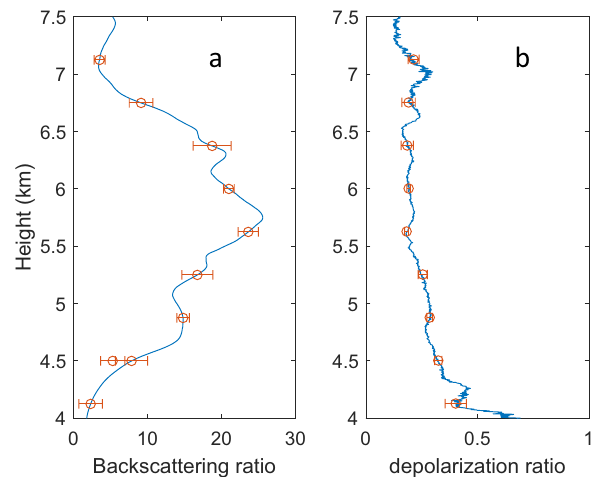
Figure 4. ( a ,left) Time series of integrated signals in 4.5–6.00 km heights, ( b ,right) FFT power of